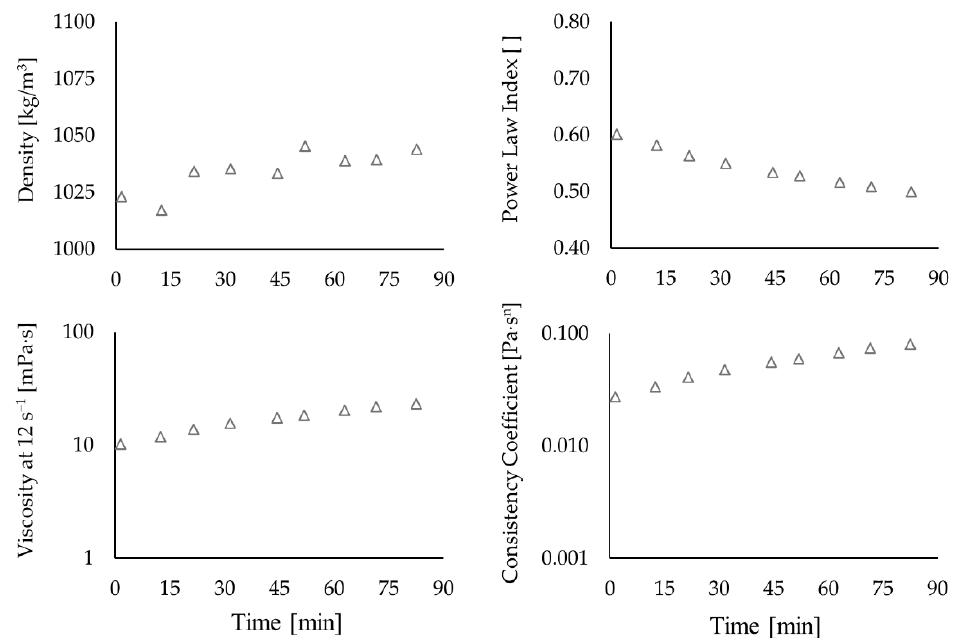
Figure A2. Photo of the continuous abiotic system.